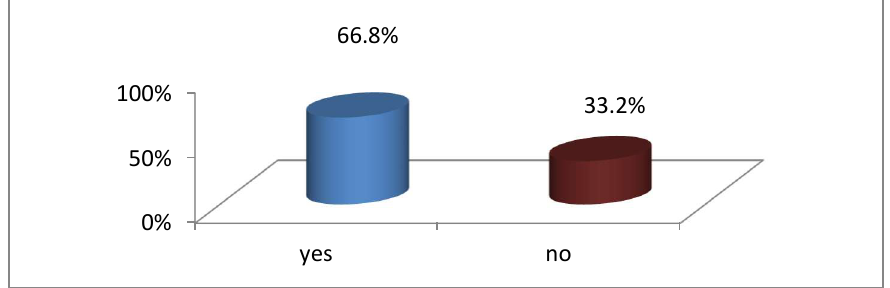
Figure 2. Respondents’ responses to the shortage of staff in the wards (N = 193).